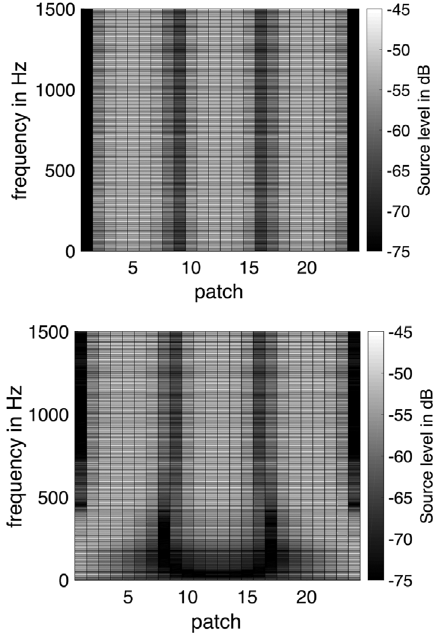
Figure 15. Comparison of the original source distribution along the 24 patches (upper) and the reconstructed source distribution (lower) as function of frequency for N p = 5. Reconstruction based on far- fi eld receiving positions.